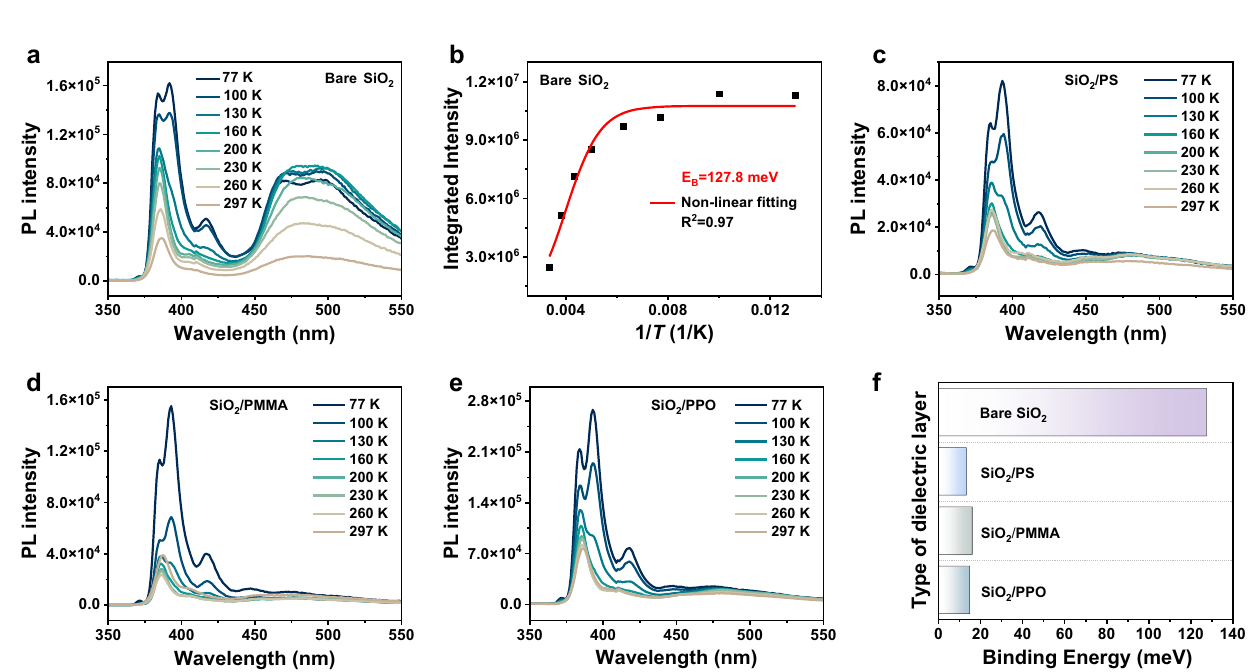
intensity based on bare SiO 2 /PMMA. d P of the phototransistor based on bare SiO 2 dielectric comparison with single-component PS, PMMA, PPO at low illumination intensity. The values and error bars in Fig. 2b and 2c were the mean value and standard deviation obtained with 10 OPT